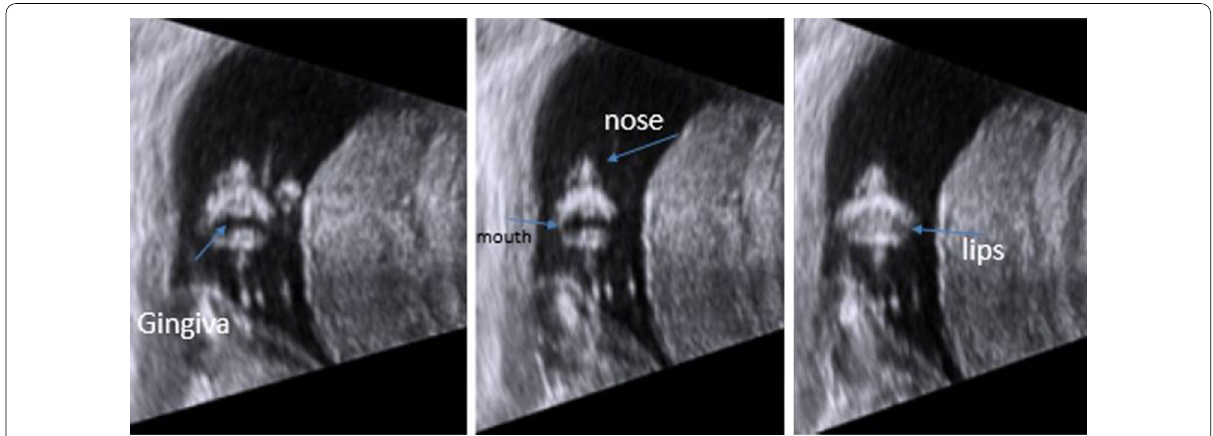
Fig. 2 21-week fetus shows the opening of the mouth and integrity of the lips and nose